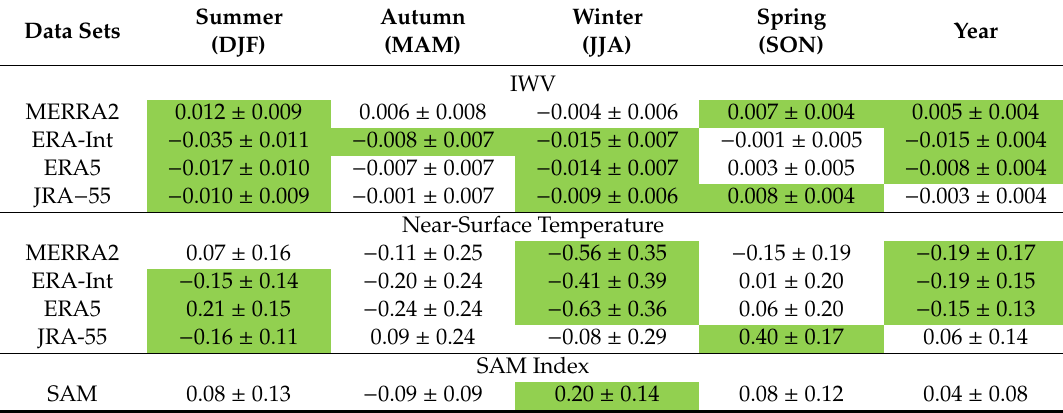
Table 2. Multidecadal trends in IWV (kg m − 2 dec − 1 ) and near-surface temperature (K dec − 1 ) from the 4 data sets (MERRA2, ERA Interim (ERA-Int), ERA5 and JRA-55) and in SAM index (index dec − 1 ) from [30] along with 1- σ error over the 38-year period (1980–2017), based either on seasonal or annual averages. Significant multidecadal trends are highlighted in